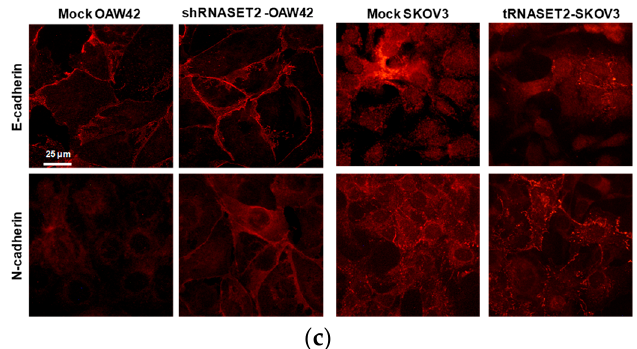
Figure 2. RNASET2 depletion causes phenotypic changes in EOC cellular models. ( a ) Real-time RT-PCR showing the transcript levels of RNASET2, CDH1, and CDH2 in mock/shRNASET2-OAW42 and mock/tRNASET2-SKOV3 cells. Results are presented as relative expression normalized to GAPDH mRNA levels. Error bars, SD. ( b ) Left panel: Western blotting on lysates from mock/shRNASET2-OAW42 and mock/tRNASET2-SKOV3 cells. Immunoblottings were performed with Abs against the proteins reported on the left. β -actin was used as control for gel loading. Right panel: quantitative evaluation of the proteins in three experiments. The graph reports the ratio between the target protein and β -actin. Asterisks indicate statistically significant values by Student’s t -test (* p < 0.05; ** p < 0.01). ( c ) Immunofluorescence (IF) analysis on fixed mock/shRNASET2-OAW42 and mock/tRNASET2-SKOV3 cells performed with Abs reported on the left.